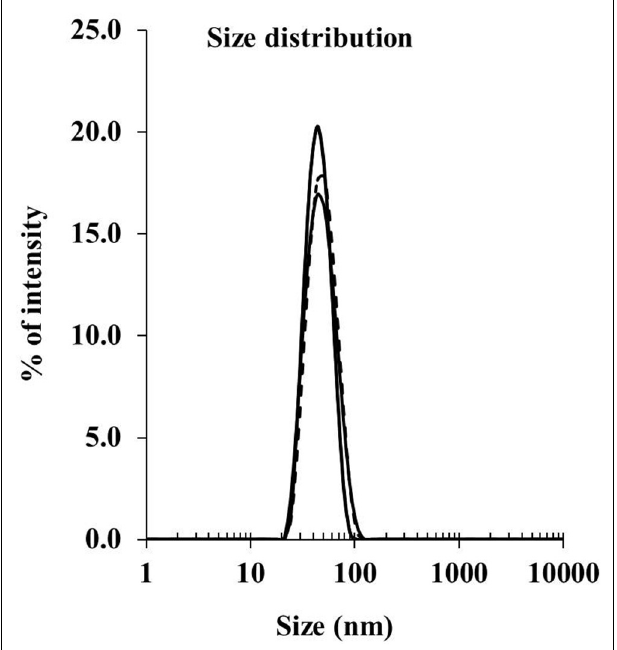
FIGURE 1 | Size distribution for PSNPs-KI formulations. SYIPSAEKI peptides were covalently conjugated to PSNPs, and the final sizes were measured by dynamic light scattering instruments